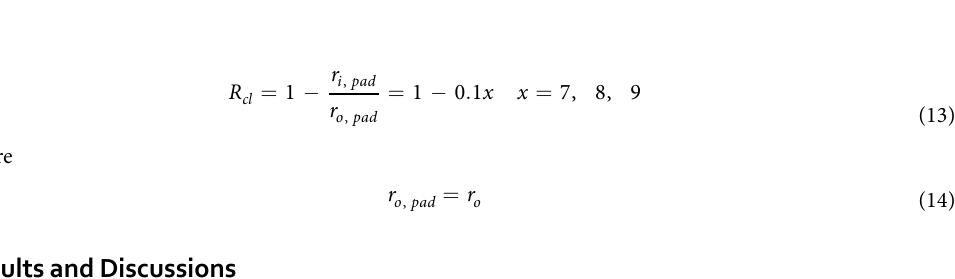
Figure 5. Non-dimensional vertical displacement versus the non-dimensional radius of one side contact with thermo-mechanical load: (i) in the FGMs rotating brake disk with different R cl and n = 1.5 (ii) in the rotating brake disk with R cl = 0.375 and different values of the grading index,